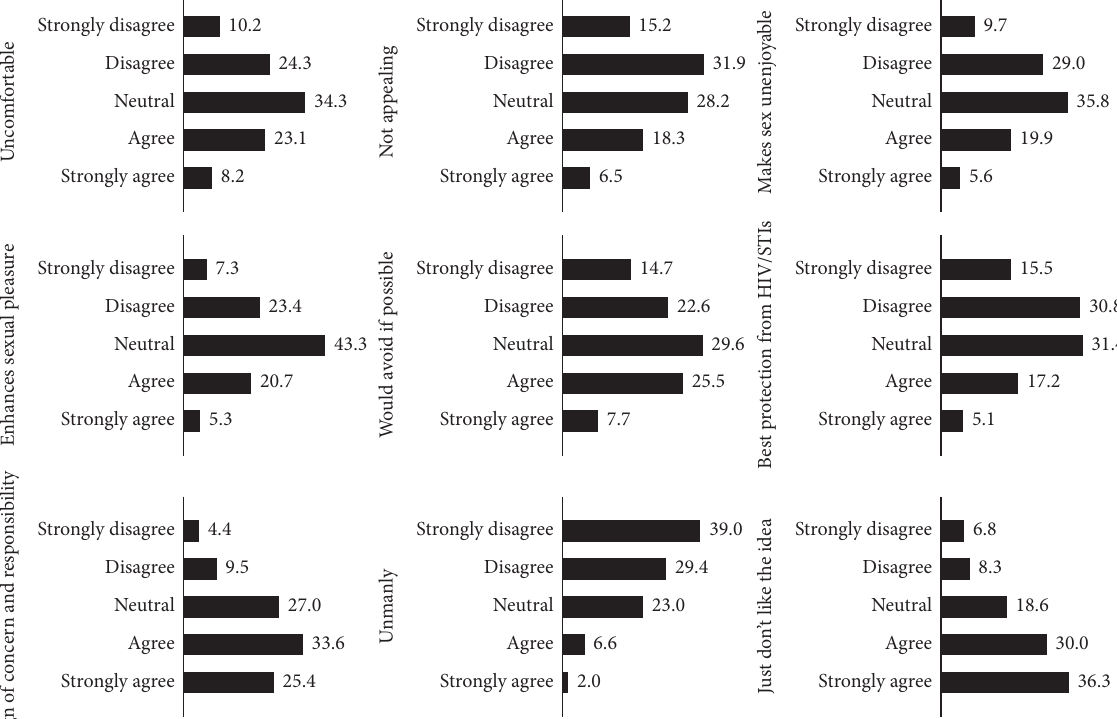
Figure 1: Responses on condom knowledge and attitude.